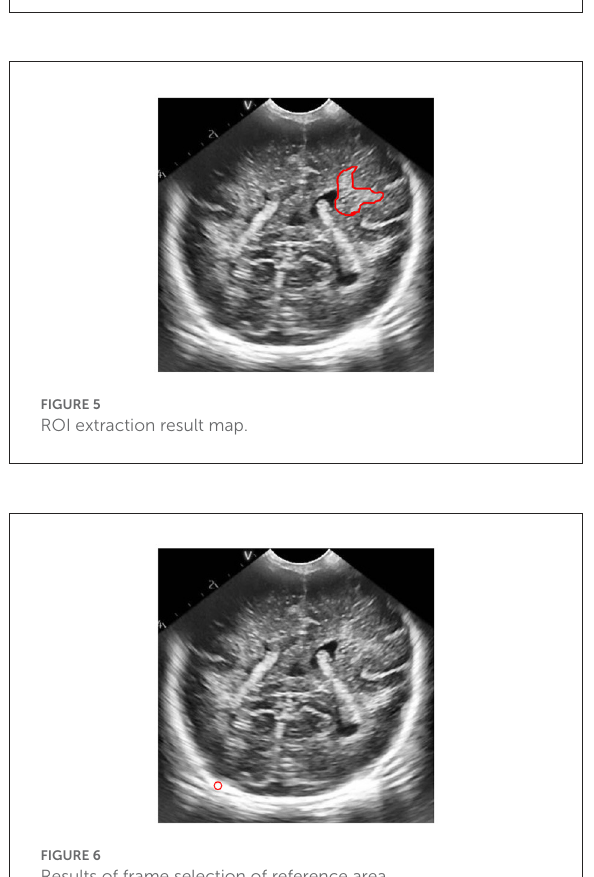
FIGURE6 Results of frame selection of reference area.